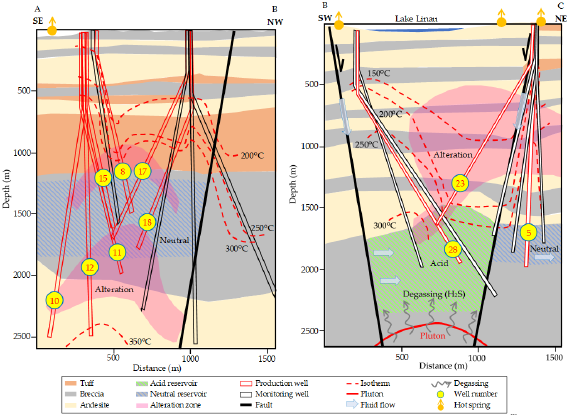
Figure 2. Conceptual model of Lahendong geothermal field (Cross-section from Figure 1, A-B represents the southeast-northwest (SE-NW) section, and B-C represents the southwest-northeast (SW-NE) section.) [5,31].